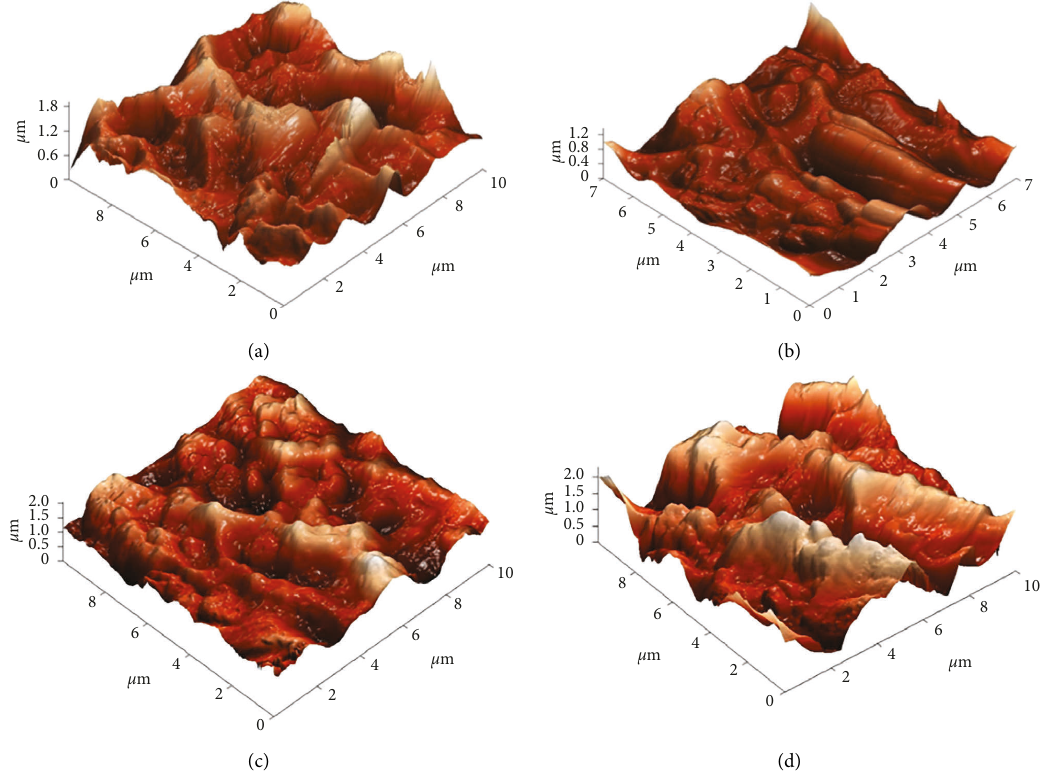
Figure 4: 3D AFM image of coated solar cell samples (a) B-II, (b) B-III, (c) B-IV, (d) B-V.